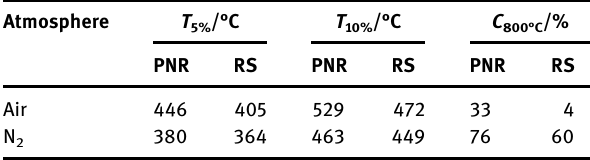
Table 3: TGA results of PNR and RS: ( a ) in air and ( b ) in N 2